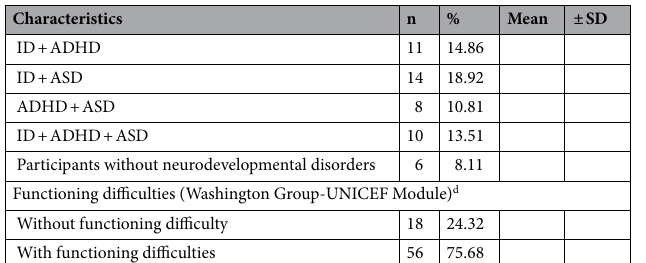
Table 1. Study population characteristics: child, parent, household, and clinical variables, Psychiatric Children’s Hospital, Mexico City, Mexico, 2017–2019 (n = 74). a Mother’s or Father’s education level: Elementary school or less (Incomplete or complete elementary school), Junior-high school (Incomplete or complete junior- high school), High school or some university (Complete high-school or incomplete bachelor’s degree), and University or more (Complete Bachelors degree or postgraduate level). b Mother’s and Father’s employment status: Unpaid (Housewife or unemployed), paid occupation (any salaried employment). c Six missing values for socioeconomic level. d Functioning difficulties according to the Washington Group-UNICEF module in at least one of the following domains: seeing, hearing, walking, self-care, communication, learning, memory, concentration, acceptance of change, behavior regulation, making friends, anxiety and depression.